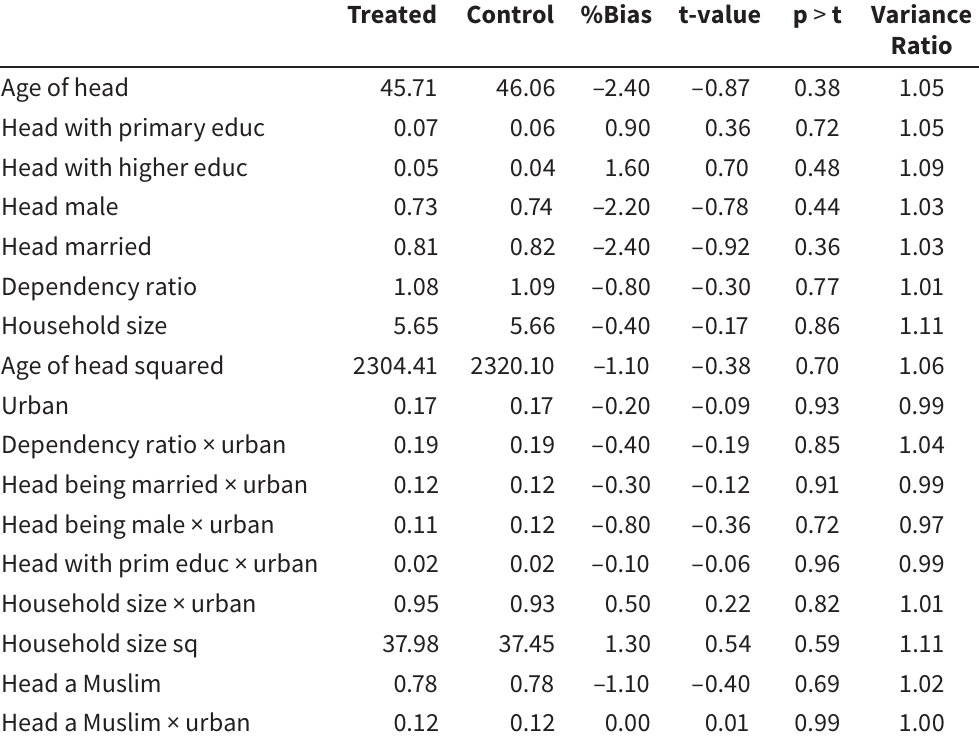
Table A2.5 Post-war (2011) Covariate balancing Tests using Conflict Exposure Treated Control %Bias t-value p > t